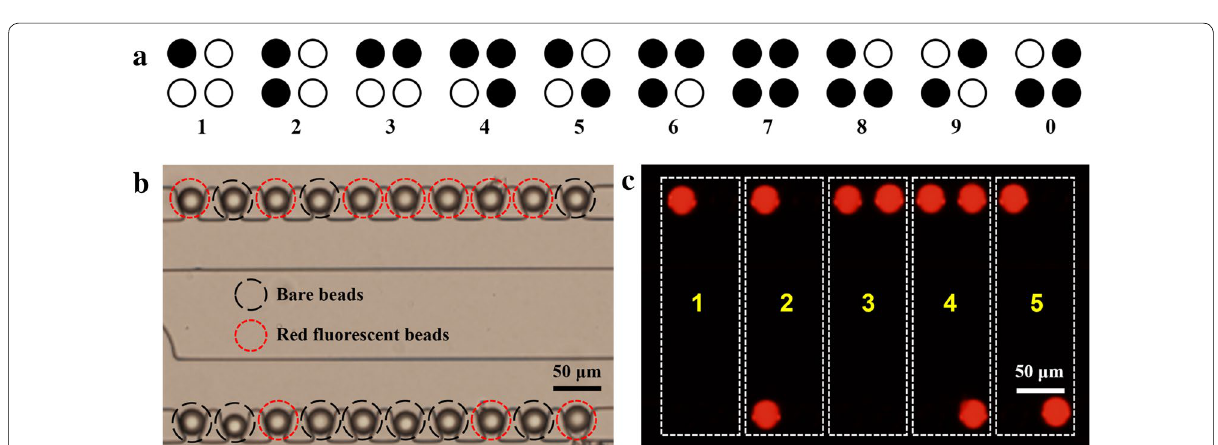
Fig. 4 2D planar pattern using two types of particles. a Braille representation of numbers from 0 to 9. b Bright-field microscopic image of arrayed particles composed of the combination of bare and red-fluorescent particles. c Fluorescent image revealing the planar pattern that displays the Braille numbers 1, 2, 3, 4, and